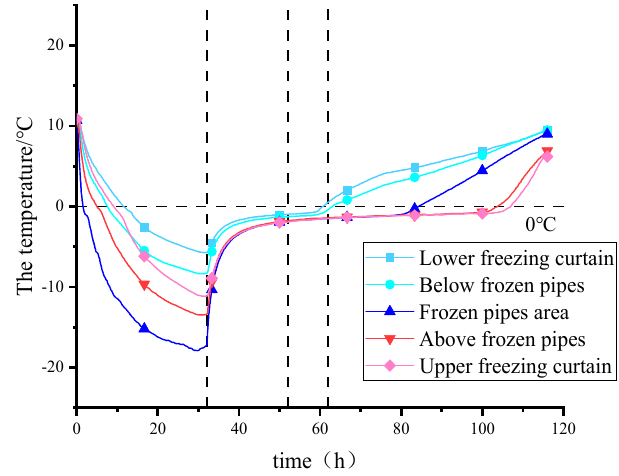
Figure 6. Temperature distribution during the model test.